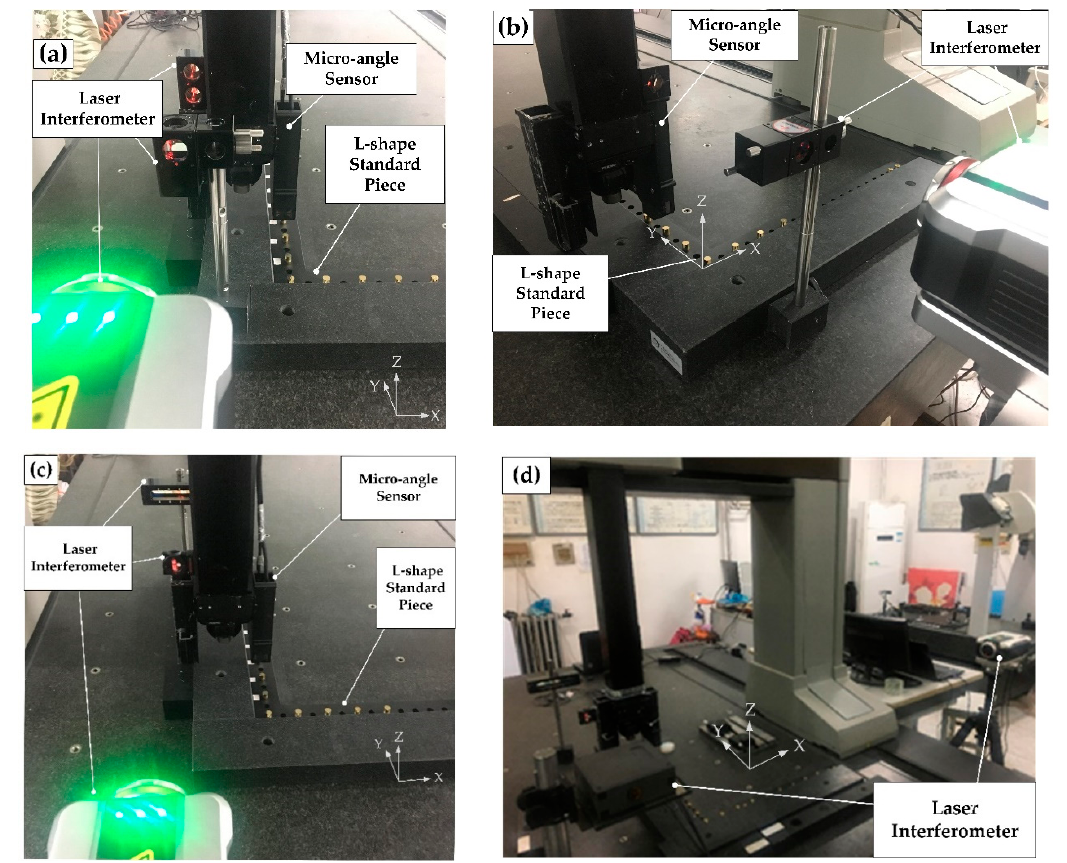
Figure 10. Verification setup of the proposed system in the XOY plane: ( a ) Angle comparison experiment; ( b ) Positioning error comparison experiment; ( c ) Straightness error comparison experiment; ( d ) Squareness error measured by the laser interferometer.